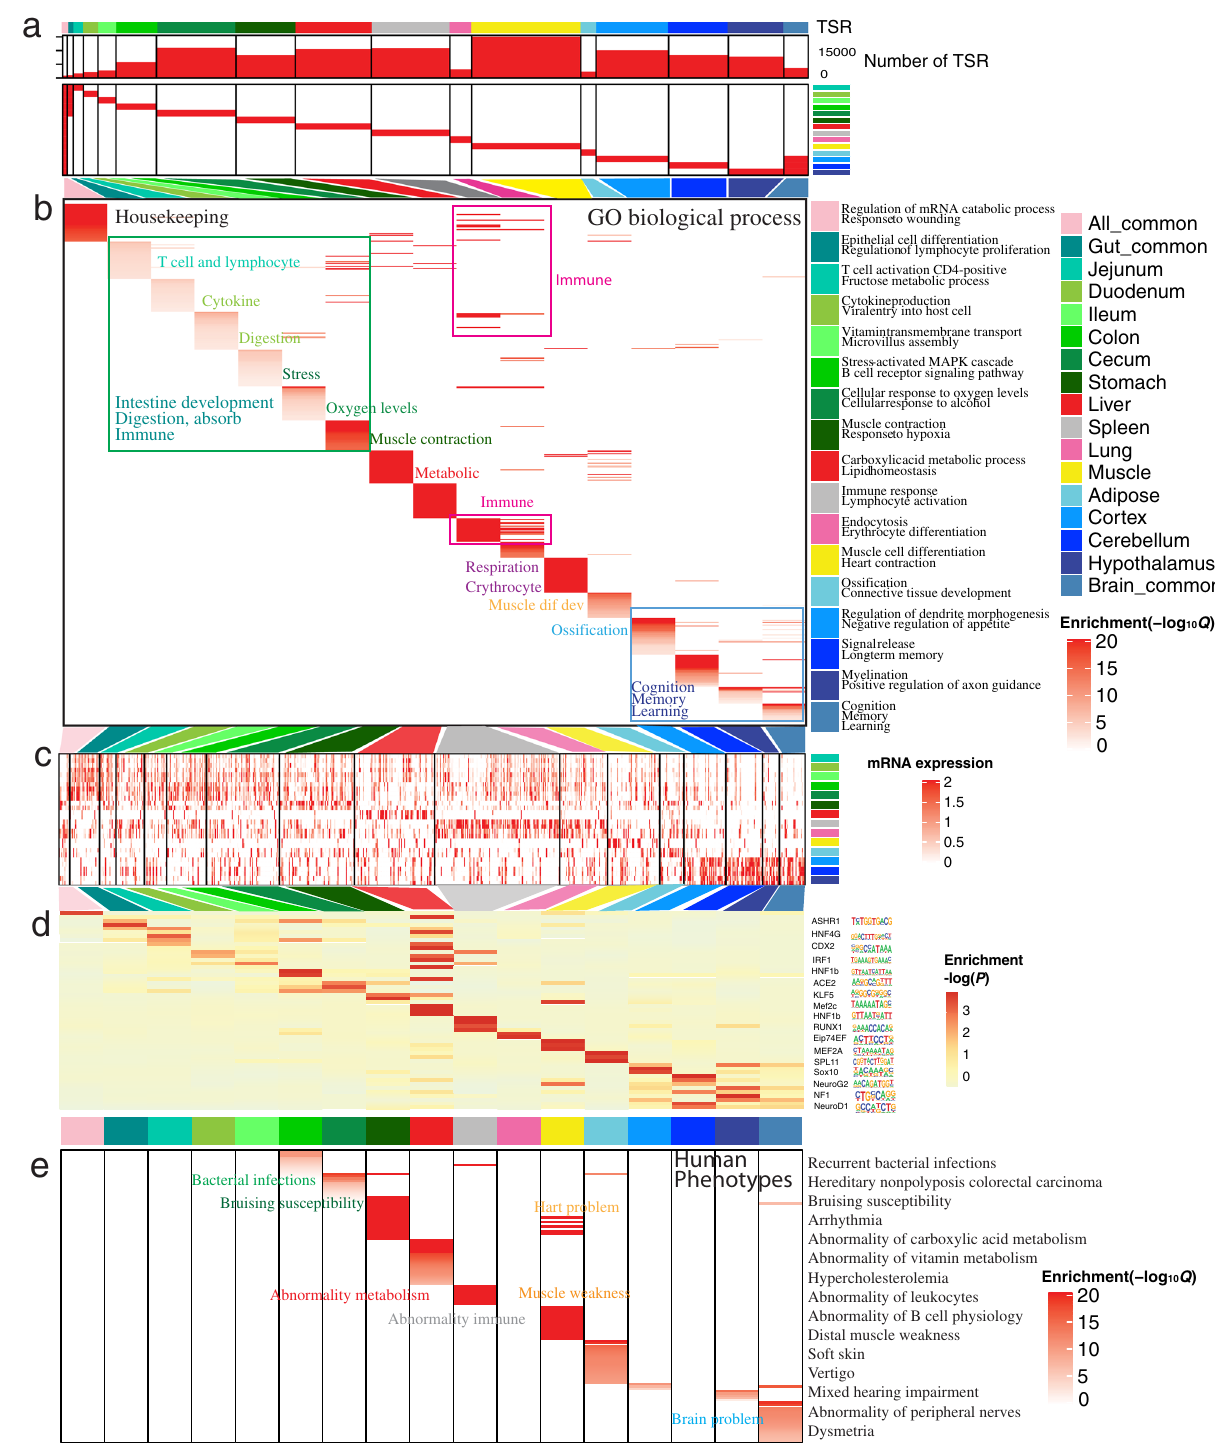
functional genome annotation for interpreting the molecular mechanisms underpinning complex traits, adaptive evolution, and gene